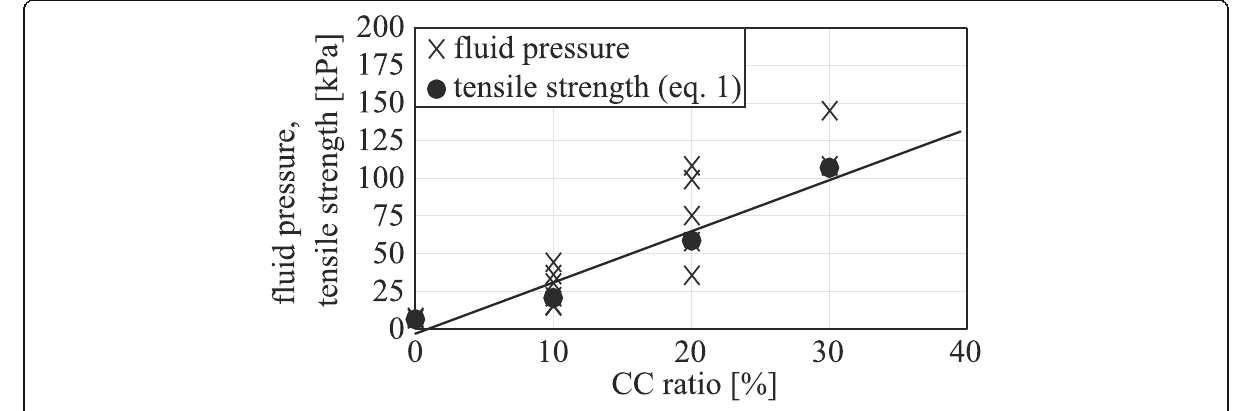
Fig. 9 Fluid pressure and tensile strength versus CC